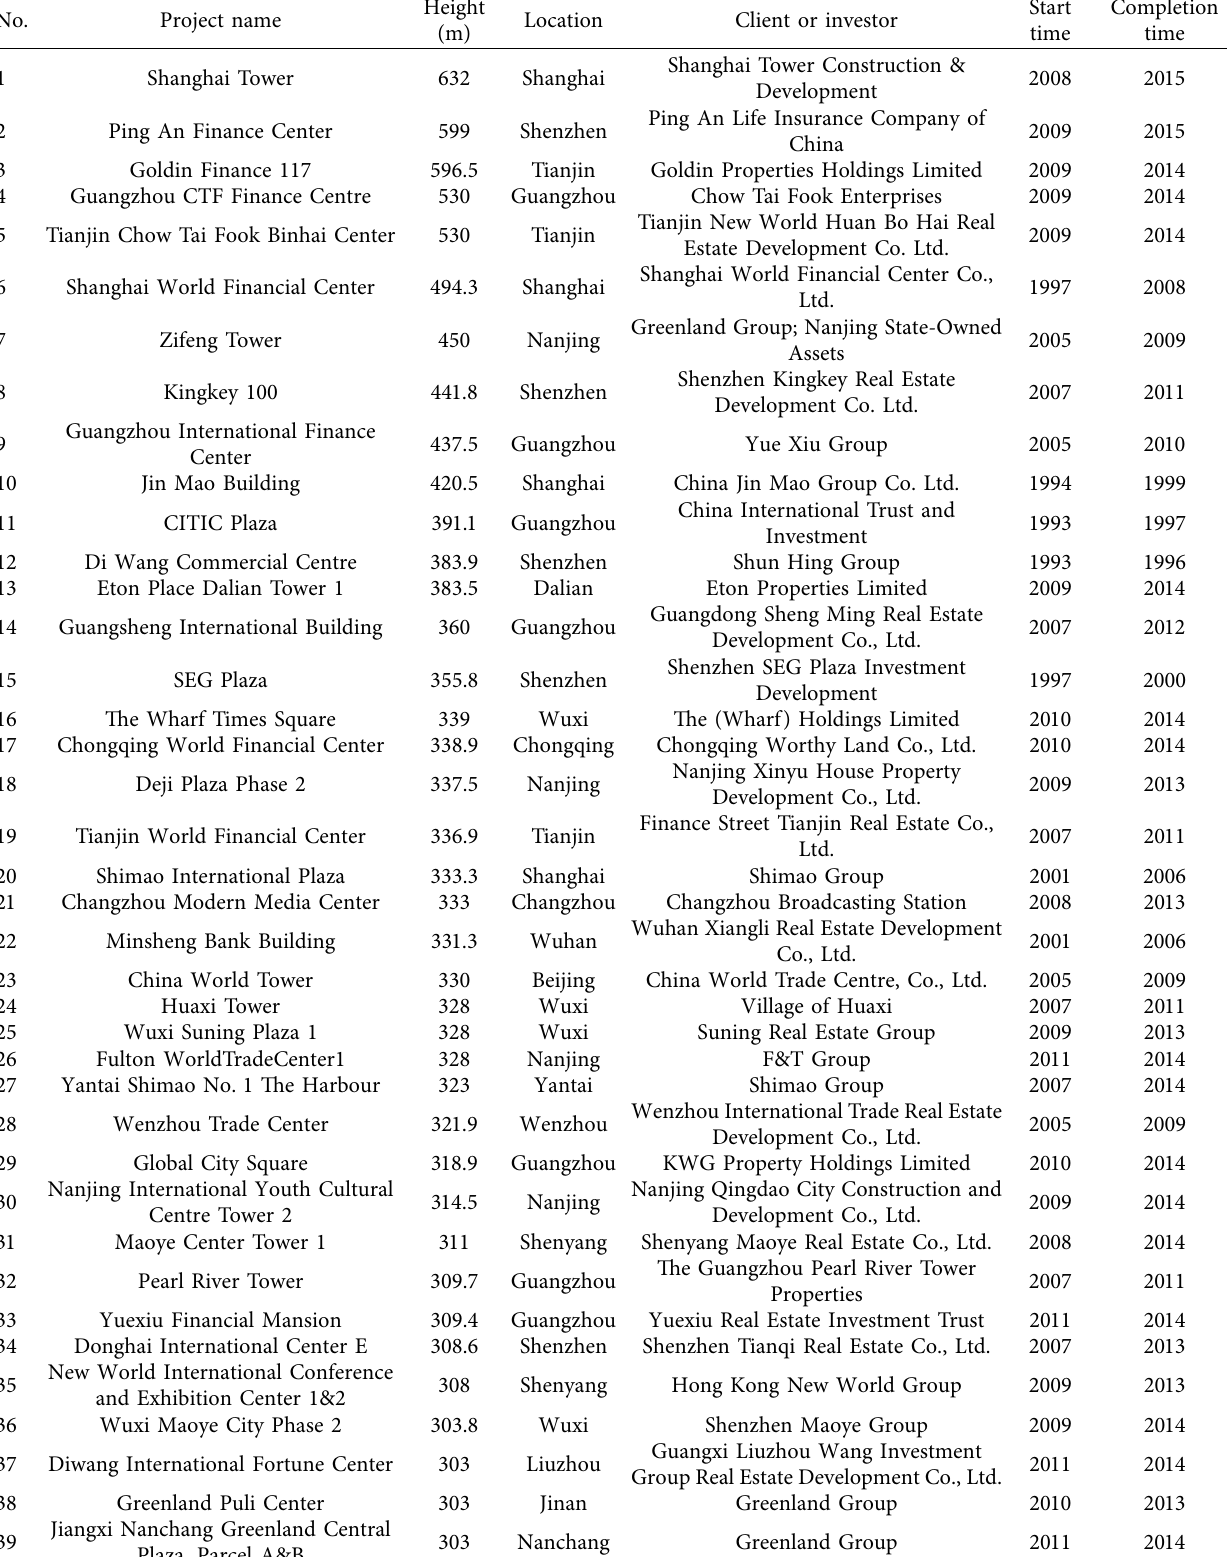
Table 1: General information of 43 skyscrapers above 300